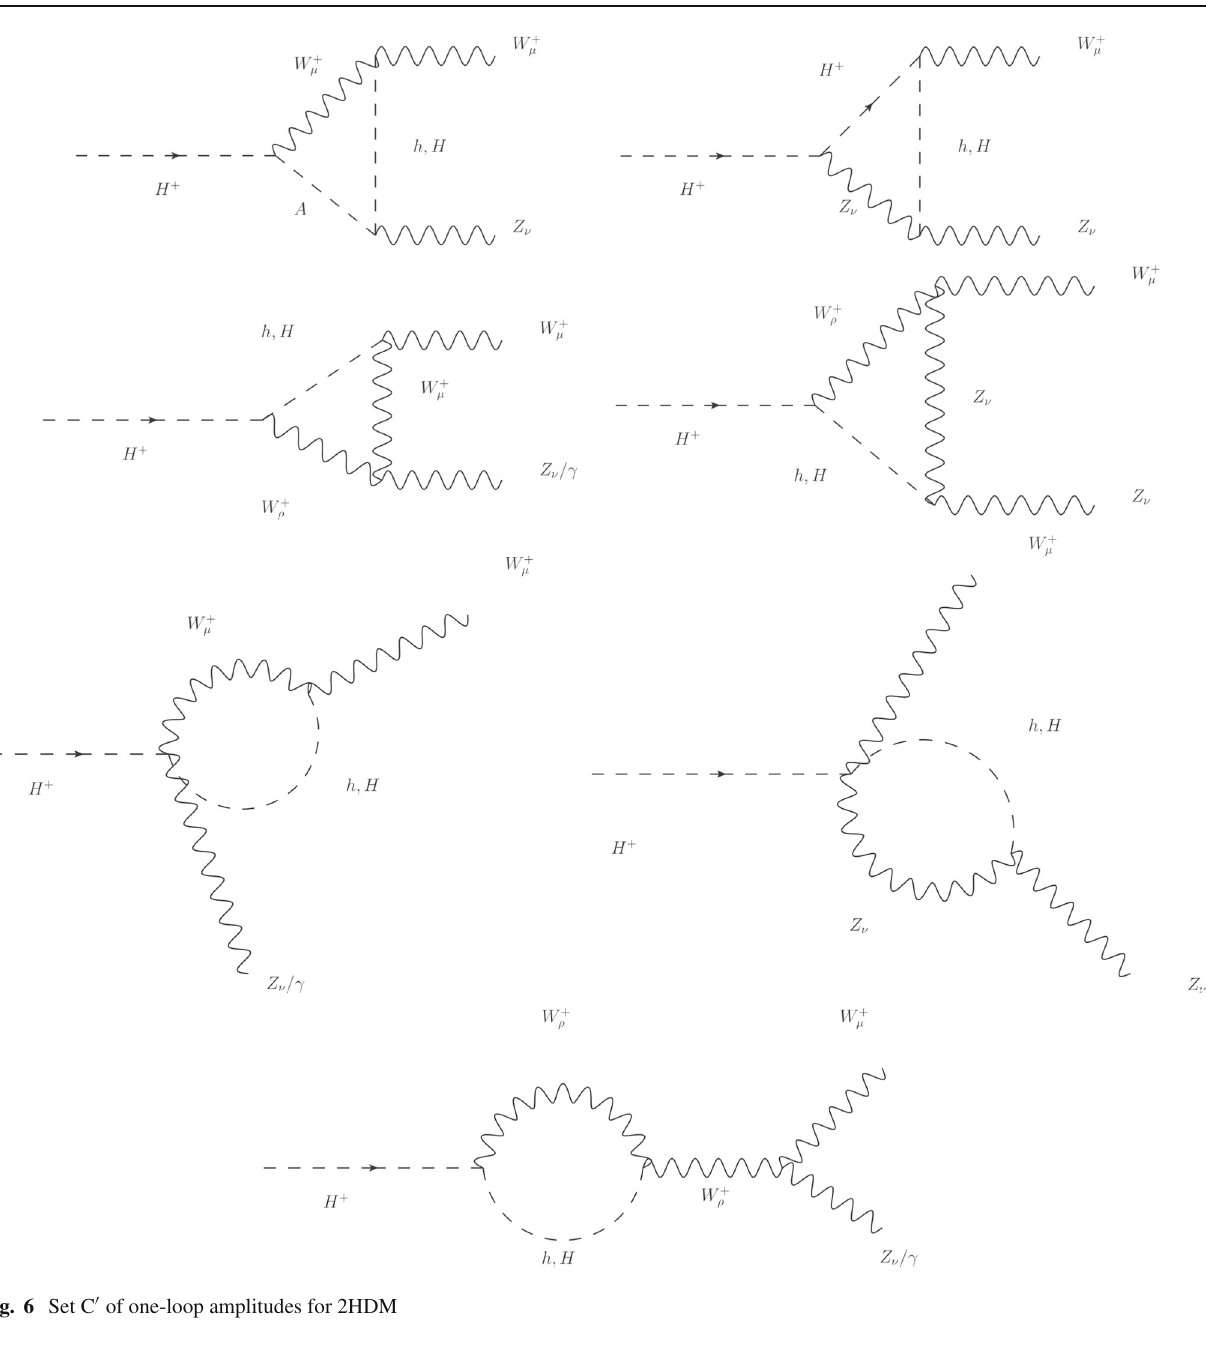
where i = L ( T ) represents the longitudinal and transverse polarization and, λ( a , b , c ) = ( a − b − c ) 2 − 4 abc , ω = ) 2 , z = ( M Z ) 2 ( M W M H + M H +